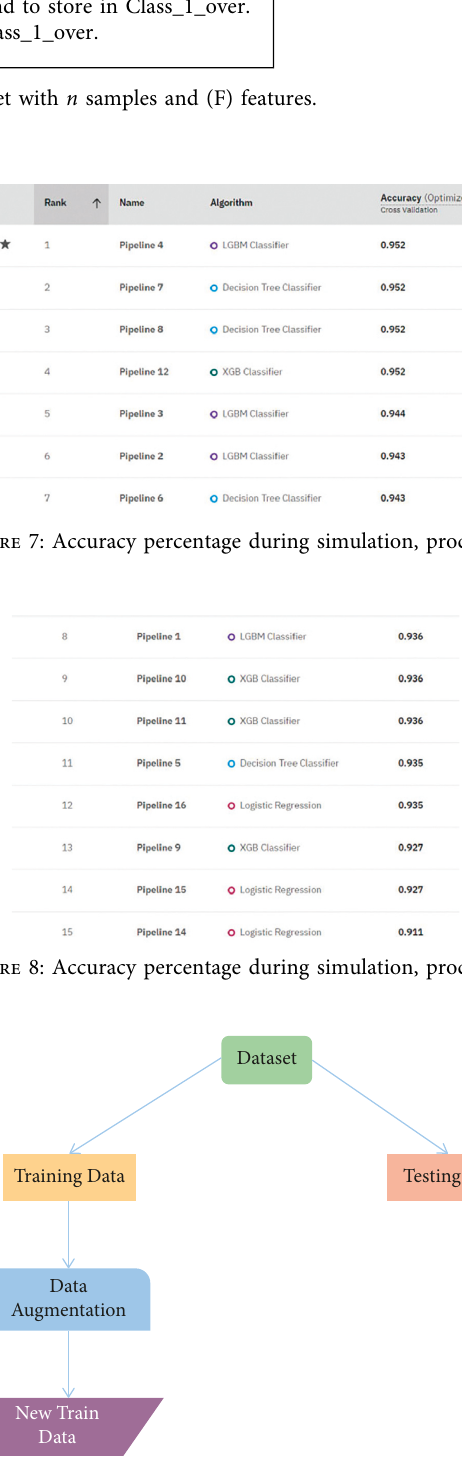
Figure 9: Flow of the